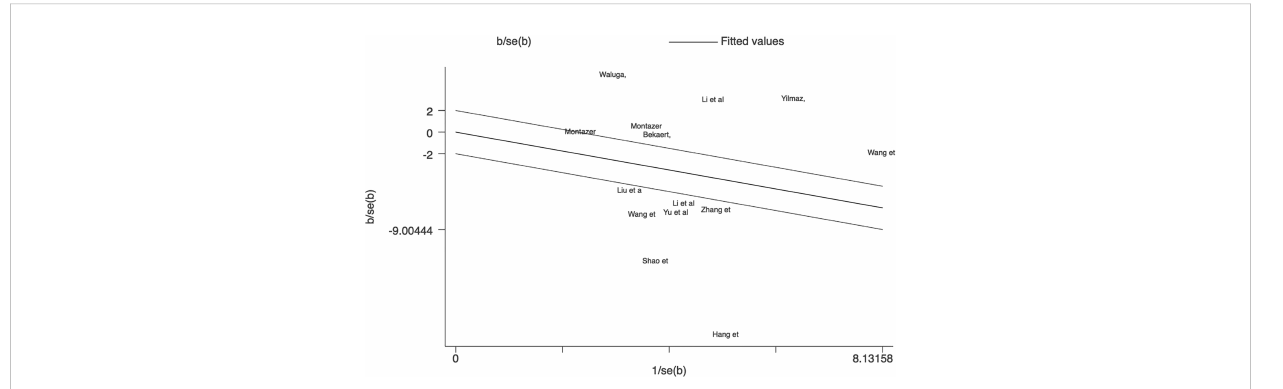
FIGURE 3 Galbraith test result of circulating omentin levels between MAFLD and healthy control group. Galbraith ’ s test showed that most of the studies were not within a reasonable range, which indicated signi fi cant heterogeneity between